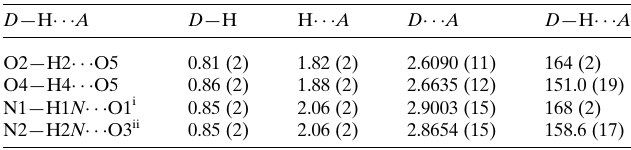
Table 1 Hydrogen-bond geometry (A˚ , (cid:3) ) for (I).